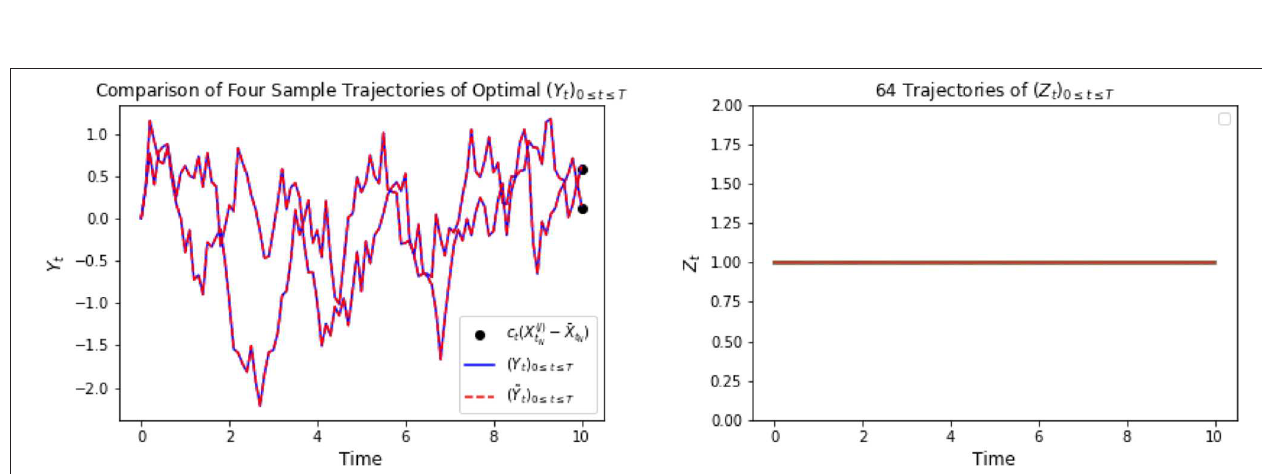
FIGURE 11 | The plot on the left shows representative trajectories of [( Y t